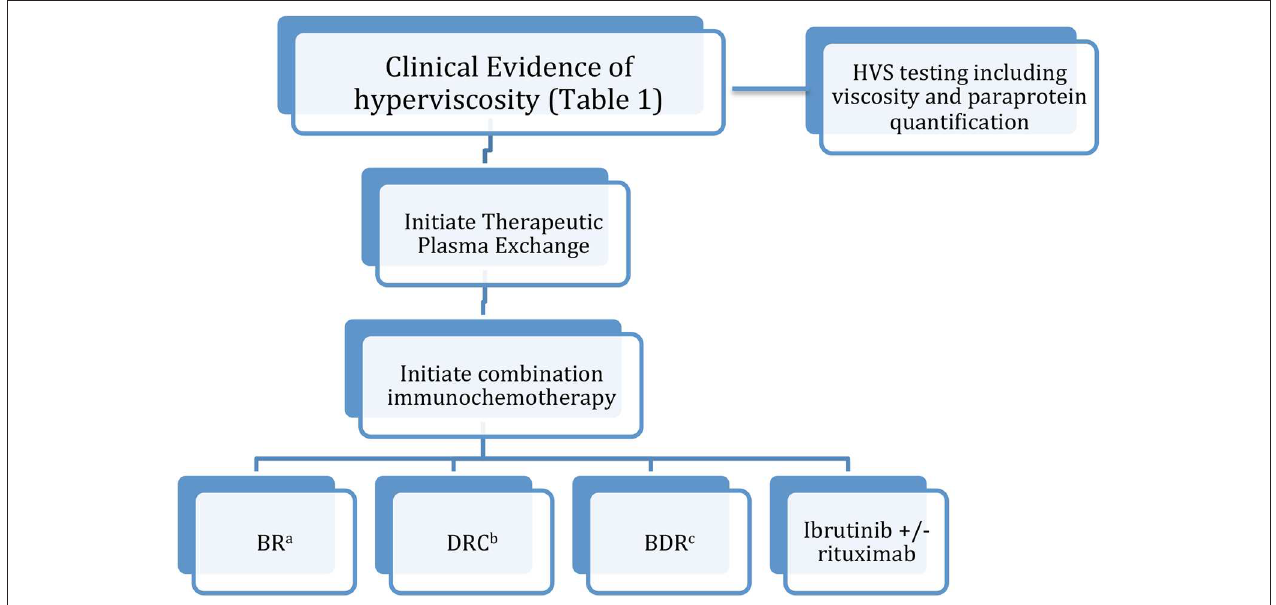
FIGURE 1 | Treatment algorithm for hyperviscosity syndrome in WM. (a) Bendamustine/rituximab. (b) Dexamethasone/cyclophosphamide/rituximab. (c) Bortezomib/dexamethasone/rituximab.